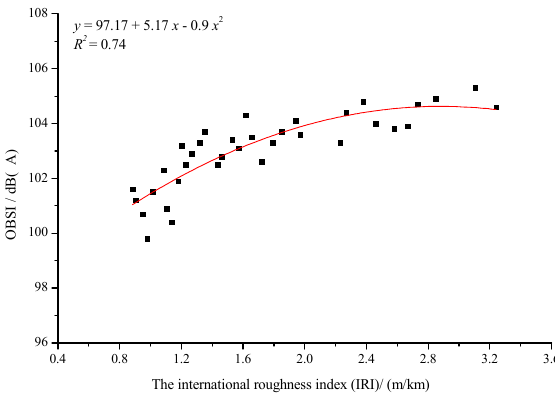
Figure 3. Regression analyses between groove concrete pavement roughness and tire/road noise.